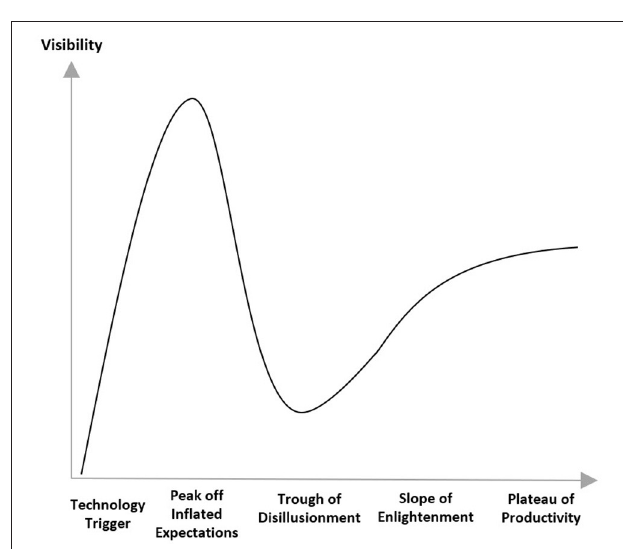
FIGURE 3 | Hype cycle